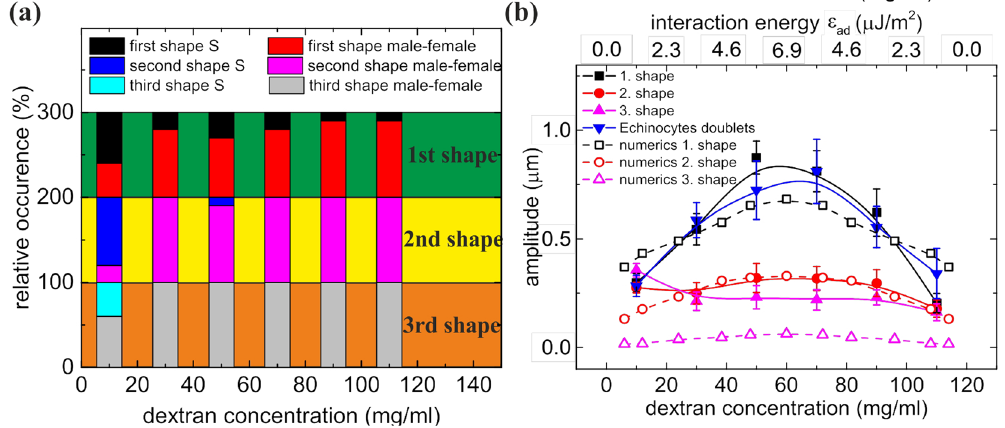
Figure 8. ( a ) Distribution of shapes within rouleaux for the first three contact zones. Only male-female and S-shapes were observed. ( b ) Amplitudes of deformation of the first three interacting membranes vs. dextran concentration in experiments and vs. interaction energy for numerics. For comparison the amplitudes of the shapes of the echinocytic doublets are shown as well.